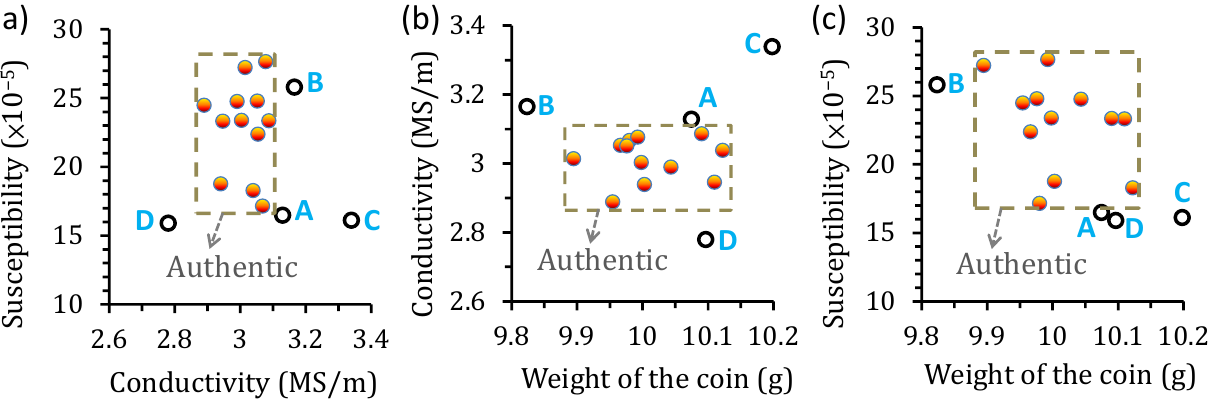
Figure 5. Electromagnetic properties and weight distribution of the 50 NTD coins: ( a ) susceptibility vs. conductivity, ( b ) conductivity vs. weight, and ( c ) susceptibility vs. weight.